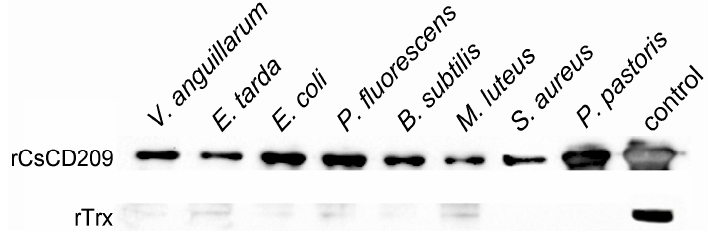
Figure 8. Western blot analysis of the microbial binding activity of rCsCD209. V. anguillarum , E. tarda , E. coli , P. fluorescens , B. subtilis , M. luteus , S. aureus and P. pastoris were incubated with rCsCD209 or rTrx. The bound proteins were separated by SDS-PAGE and immunoblotted with anti-His monoclonal antibody. The purified rCsCD209 and rTrx were loaded as the control.